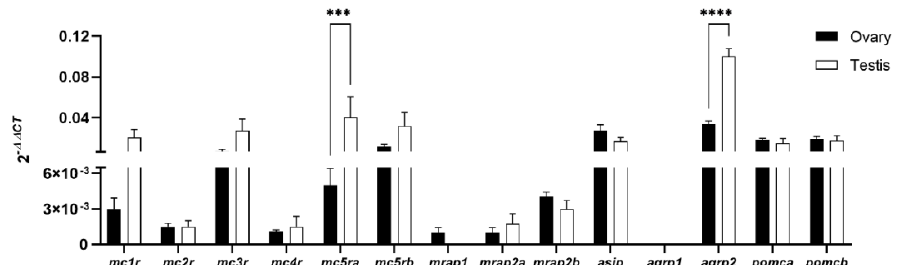
Figure 1. Relative expression levels of melanocortin-related genes in zebrafish ovaries and testes. Expression of the 18s rRNA gene was used as the reference gene for normalization of cDNA levels. Asterisk indicates significant variation after a two-way ANOVA analysis followed by Sidak’s multiple comparison test (*** p < 0.001, **** p < 0.0001). Data are expressed as mean ± SEM.